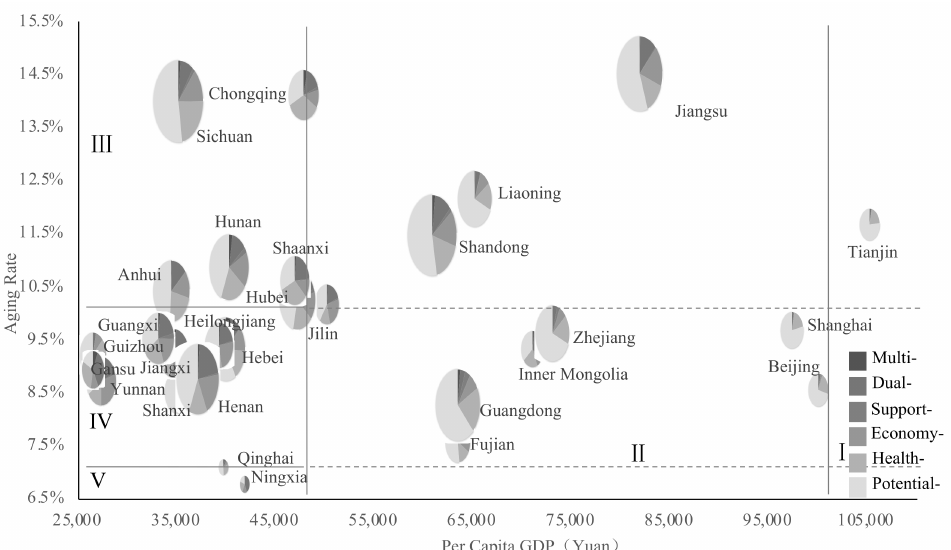
Figure 2. Distribution of vulnerable older adults in different areas. Note: To avoid overlap, the bubbles are compressed to ensure that more areas can be exposed. The multi-vulnerable group is actually bigger than the slice